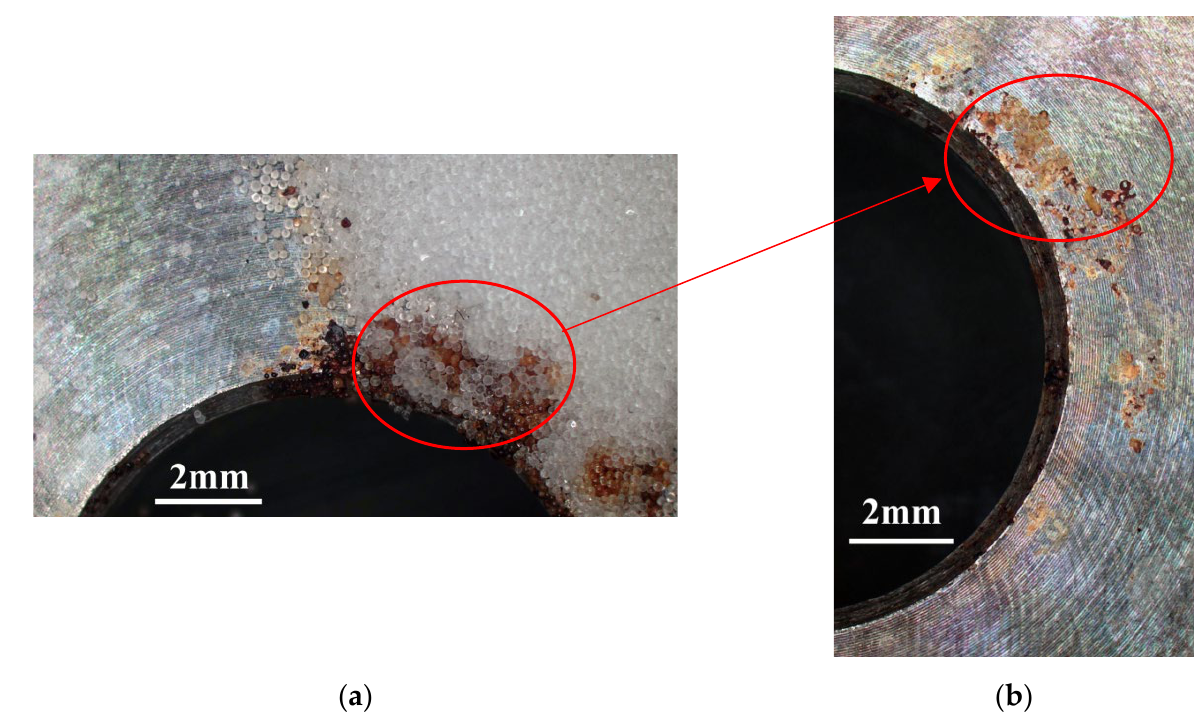
Figure 4. Macrographs of the corrosion regions of those samples with a chloride concentration of 1 g/m 2 at RH = 70%: ( a ) Specimen before cleaning and ( b ) specimen after cleaning.